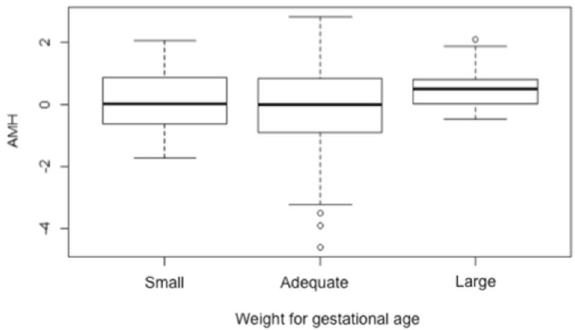
Figure 2. Boxplot of log 10 AMH in relation to SGA, AGA and LGA groups.